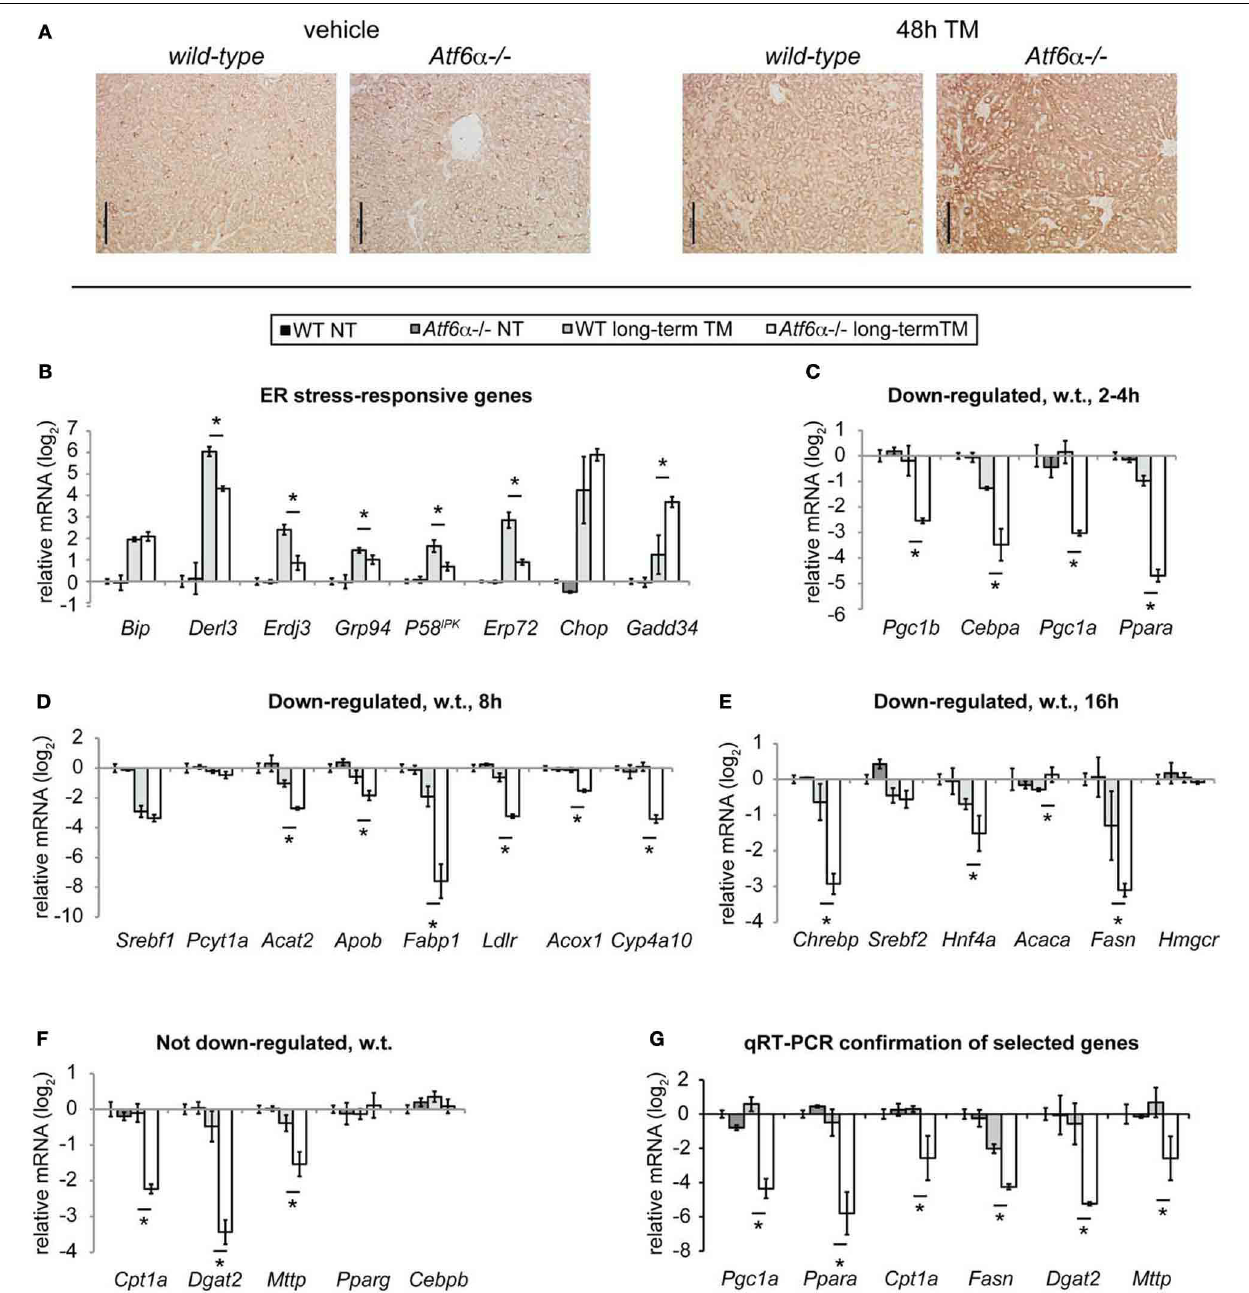
FIGURE 3 | Loss of Atf6 α exacerbates steatosis and long-term metabolic gene suppression. (A) Wild-type or Atf6 α − / − mice were challenged with 1mg/kg TM or vehicle for 48h, and ADRP immunostaining was carried out as in Figure 1 . Scale bar = 50 μ m. (B–F) Wild-type or Atf6 α − / − mice were challenged with 1mg/kg TM or vehicle for 34h, and global mRNA expression was assessed by Affymetrix microarray. Array-determined expression of the